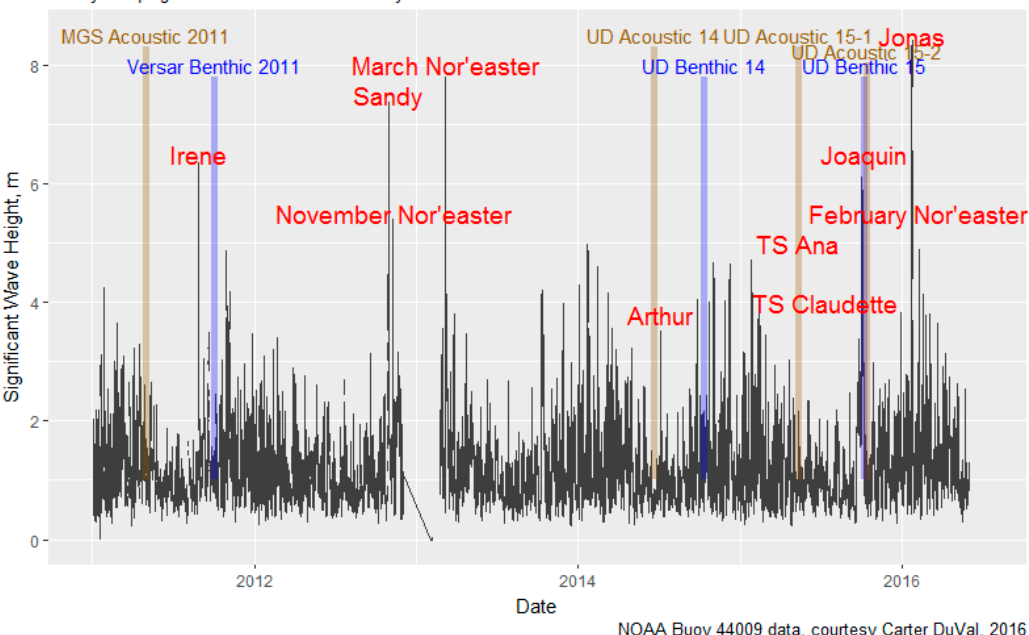
Figure 26. Significant wave height (H s ) in meters (m) at offshore NDBC Buoy 44009 (38.461 N 74.703 W) between 2011–2016 including the passage of hurricanes Sandy and Joaquin near the study site.